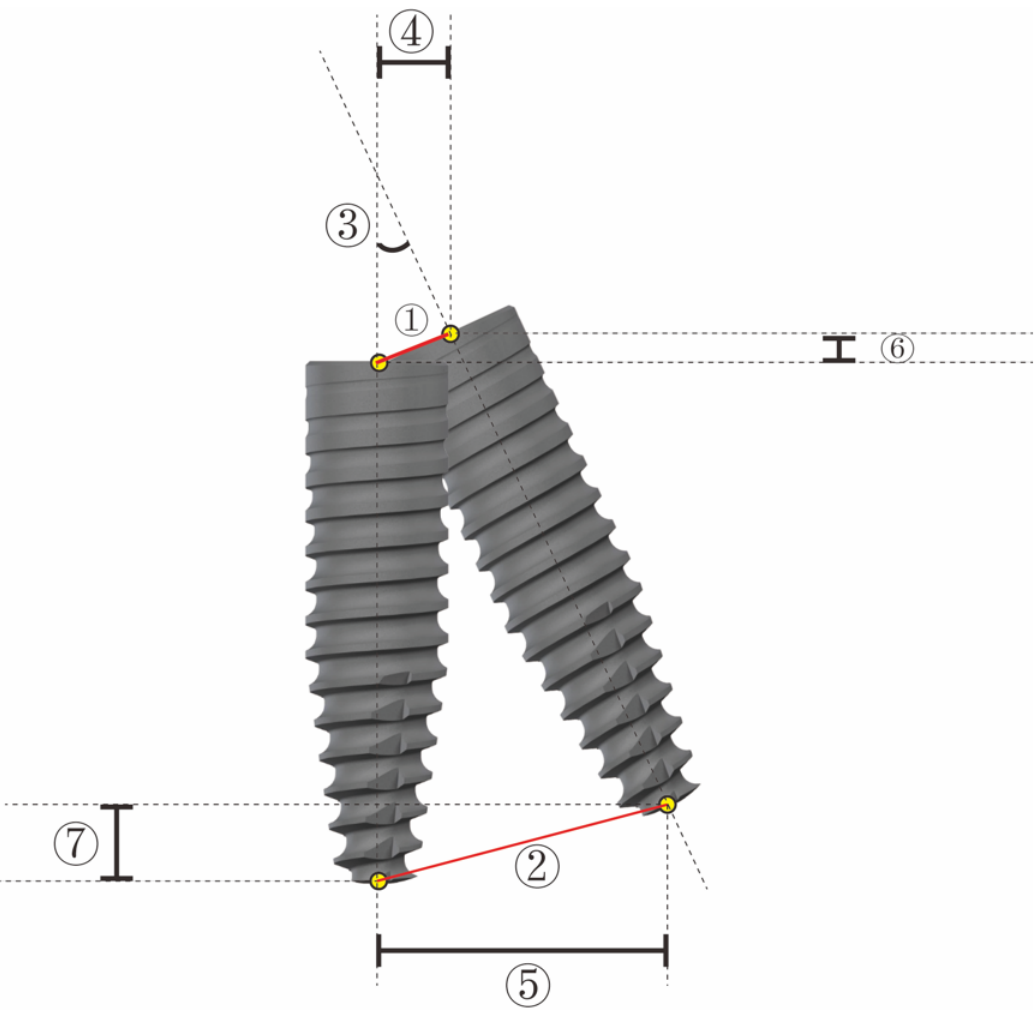
Figure 5. Parameters used to analyze deviations between the planed and inserted implants. ① entry deviation (3D deviation in the coronal aspect of the alveolar ridge); ② apex deviation (3D deviation in the apical area of the implant); ③ angular deviation. ④ entry Horizontal deviation ⑤ apex Horizontal deviation ⑥ entry Depth deviation ⑦ apex Depth deviation